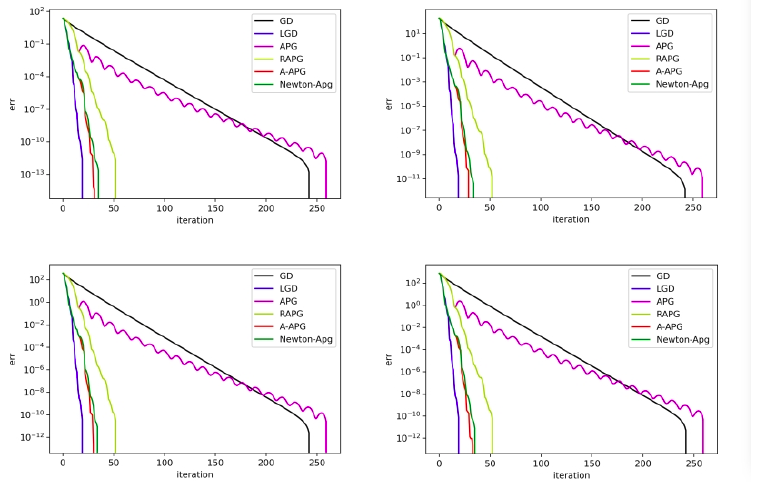
Figure 2. The error curves when n = 128, 1024, 2048, 4096 for Example